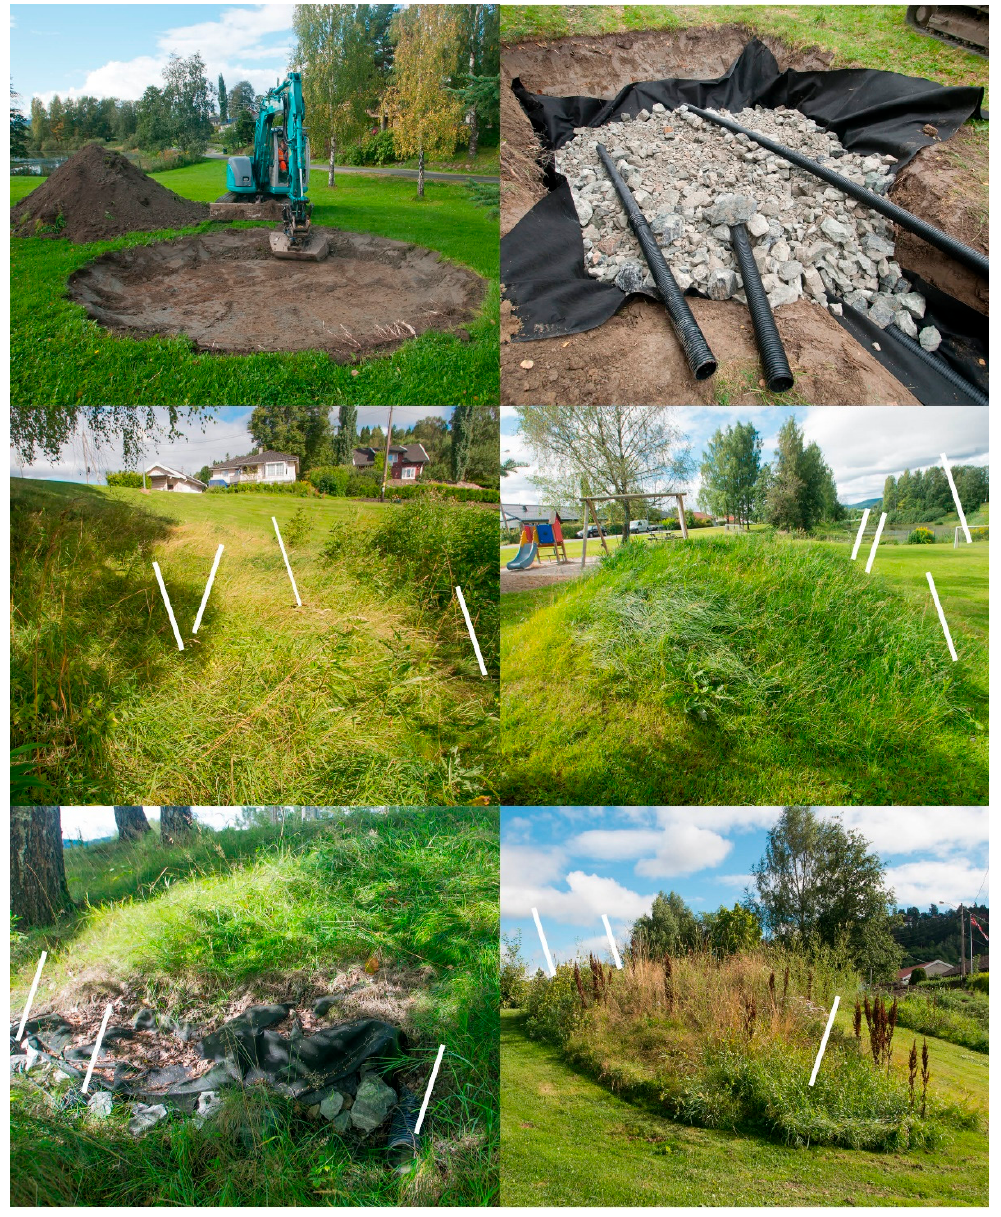
Figure A2. Photos of excavator at work during construction of Hotel 2 (top left), drainage pipes, geotextiles and rocks of Hotel 1 (top right), and final result of Hotel 1 (mid left), Hotel 2 (mid right), Hotel 3 (bottom left) and Hotel 4 (bottom right).